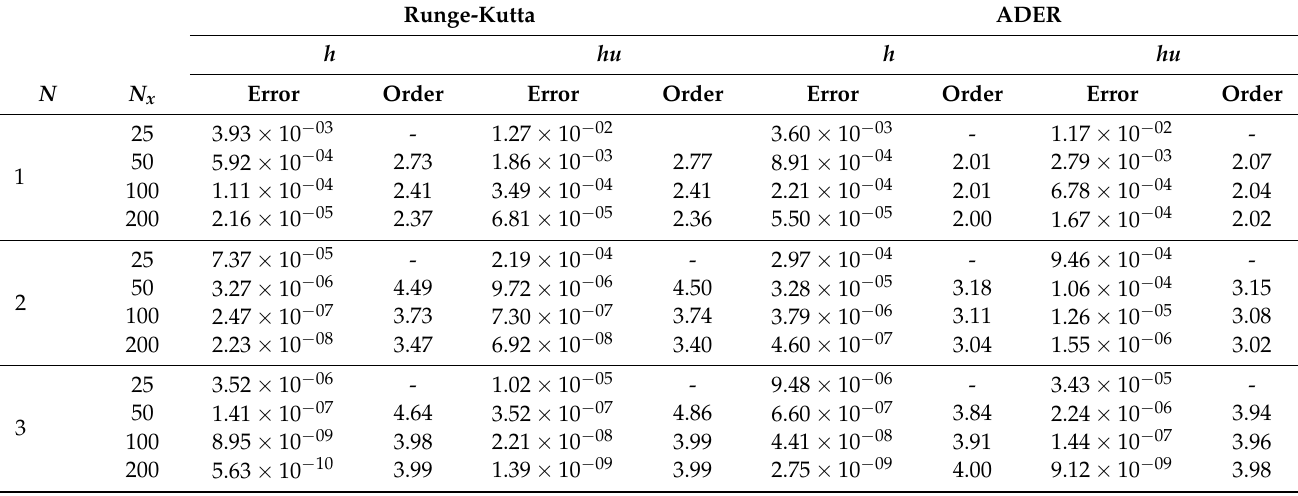
Table 2. Numerical convergence results for the initial condition (50) (shallow water equations). High- order Runge–Kutta and ADER DG schemes of order N + 1 = 2, 3, 4. Uniform Cartesian meshes